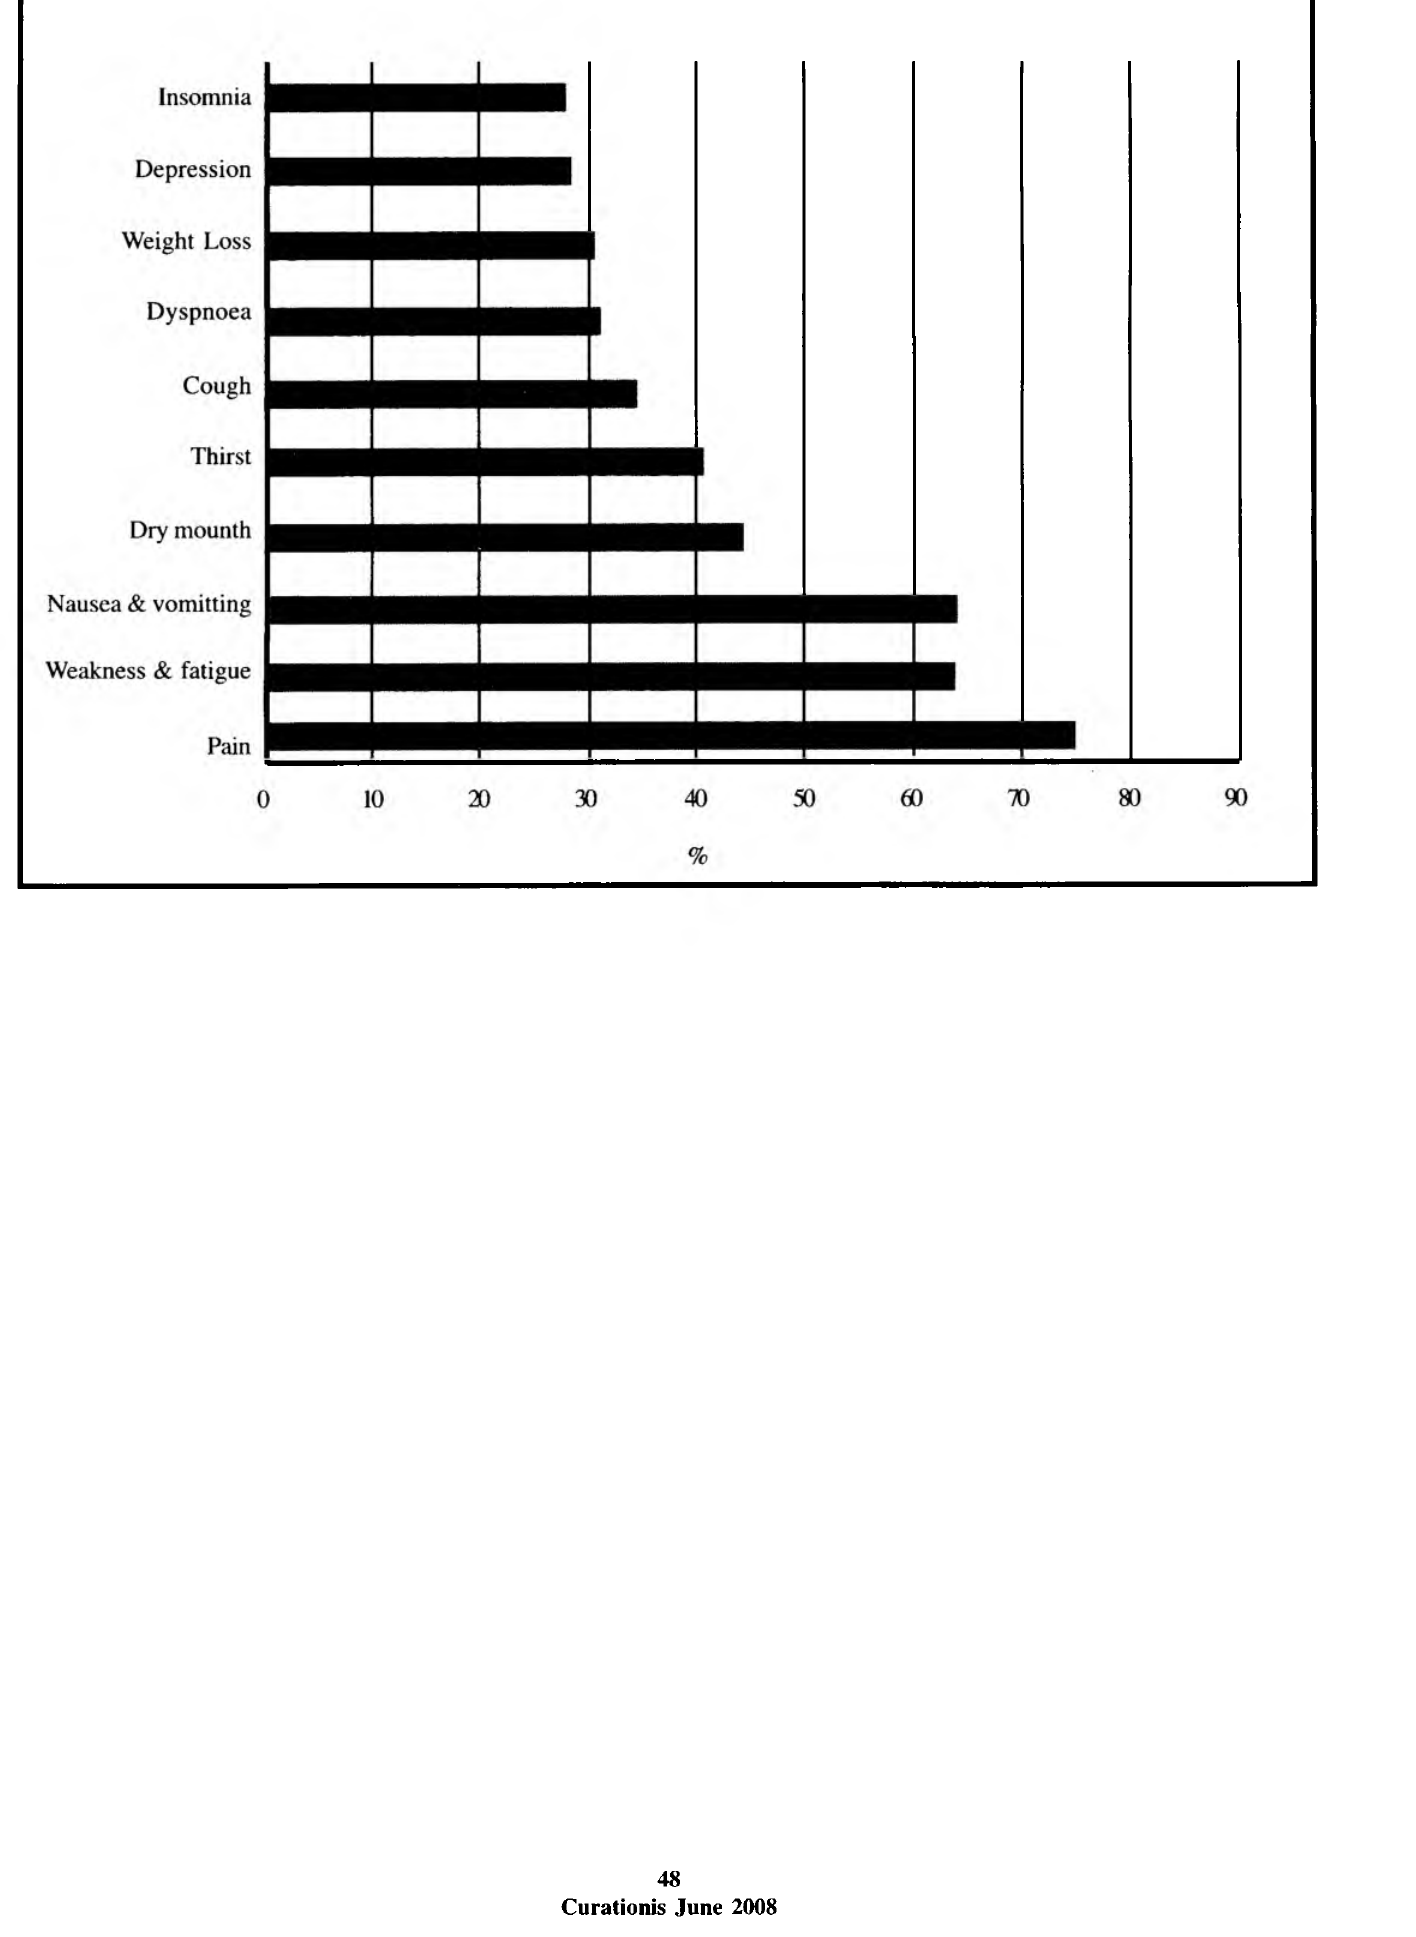
Figure 2: The most common symptoms experienced by the